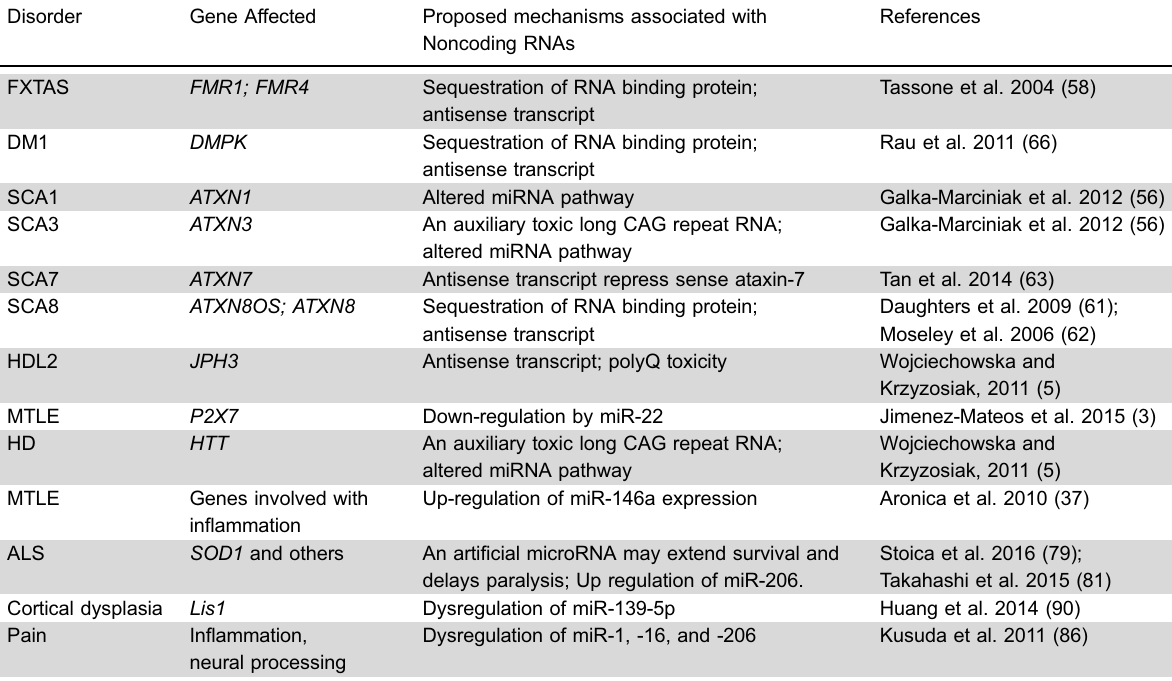
Table 1. List of ncRNAs associated with different mechanisms underlying selected neurological